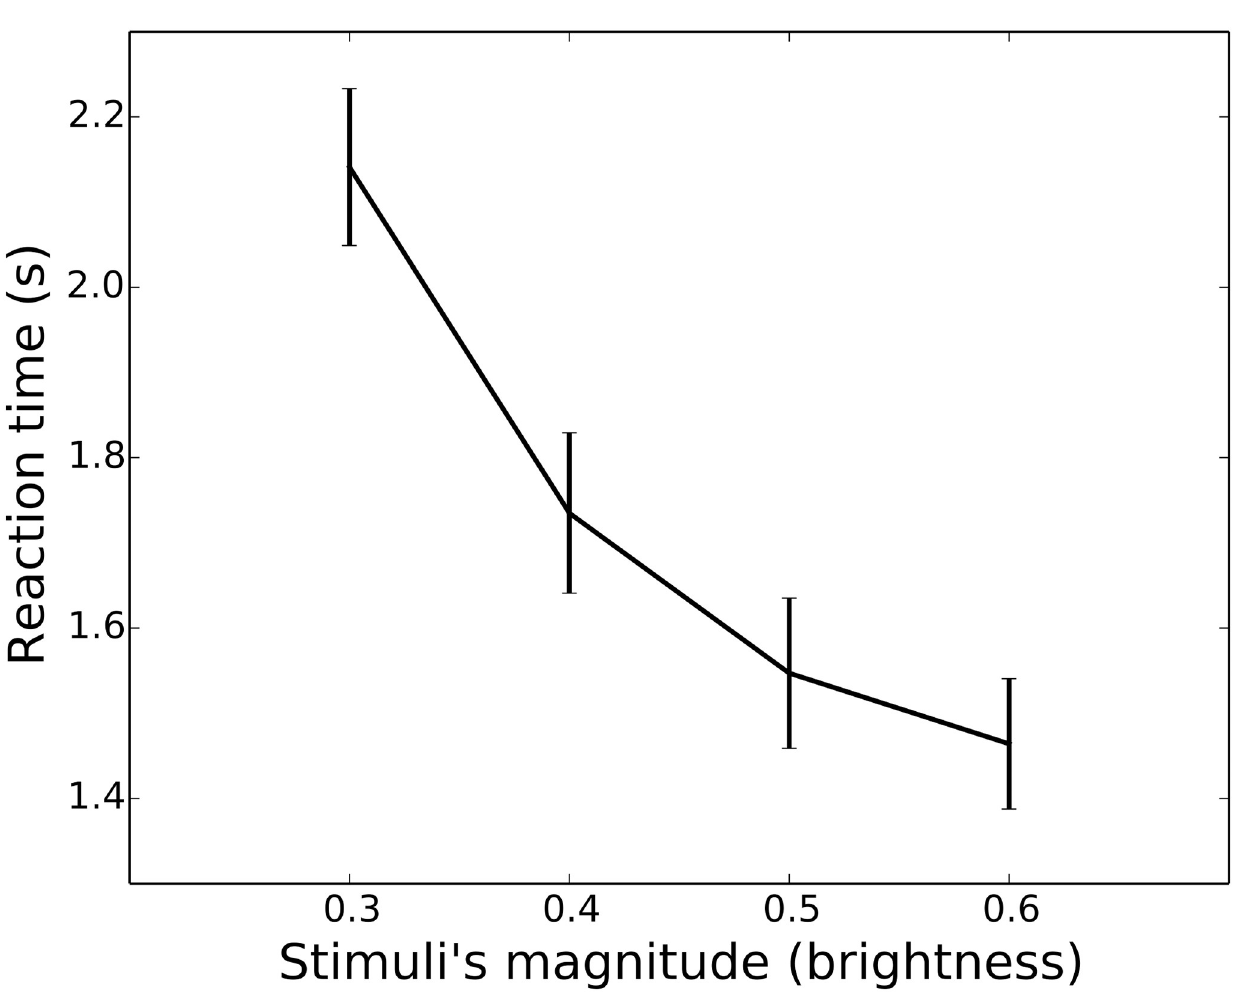
Fig 1. Empirical results from the behavioural online experiment. Decreasing reaction times as a function of the magnitude of the equal alternatives. X- axis presents mean brightness of equal alternatives (0.3, 0.4, 0.5, 0.6), on a scale of brightness from 0 to 1 in PsychoPy. Y-axis presents mean reaction times, in seconds. Bars show 95% confidence intervals. Participants experienced equal alternative conditions, interleaved with unequal alternative trials in pseudo- randomised order. Participants that performed the whole experiment experienced each equal alternative presentation ten